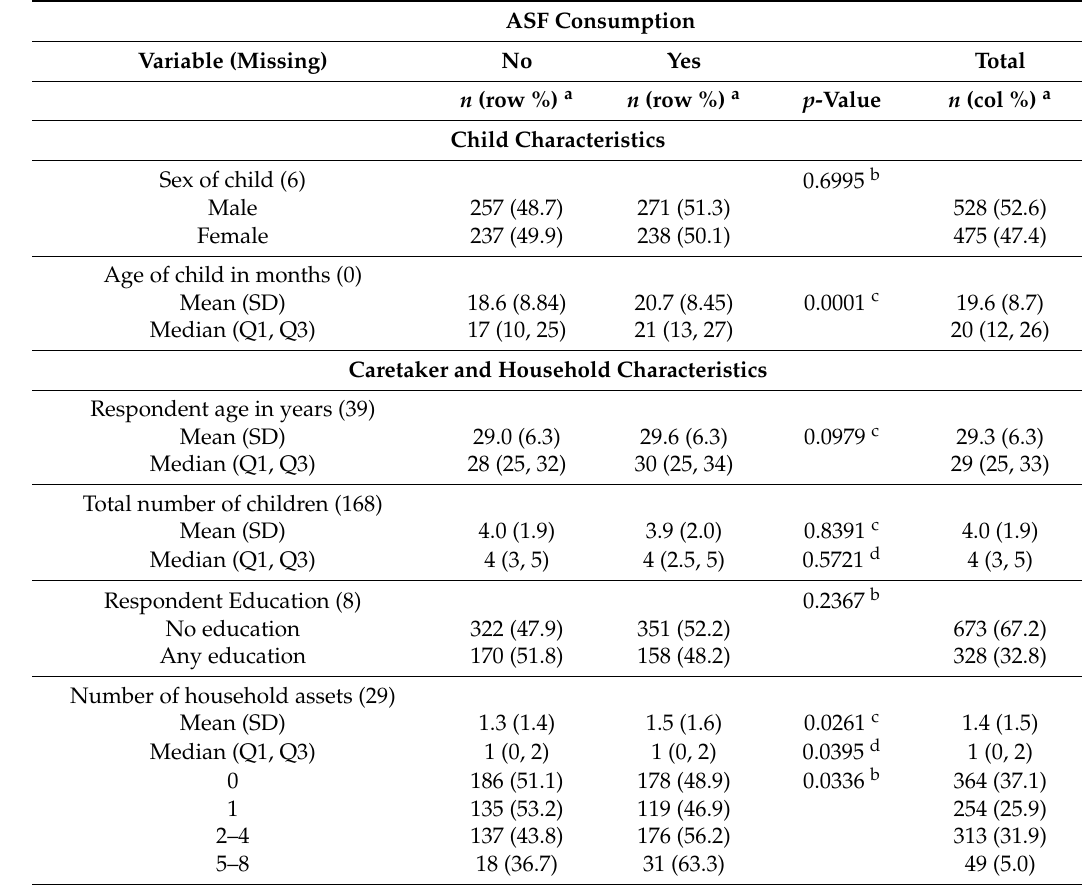
Table 1. Socio-demographic, economic characteristics, and animal source food consumption of the study participants from the four regions of Ethiopia, 2015 ( n =